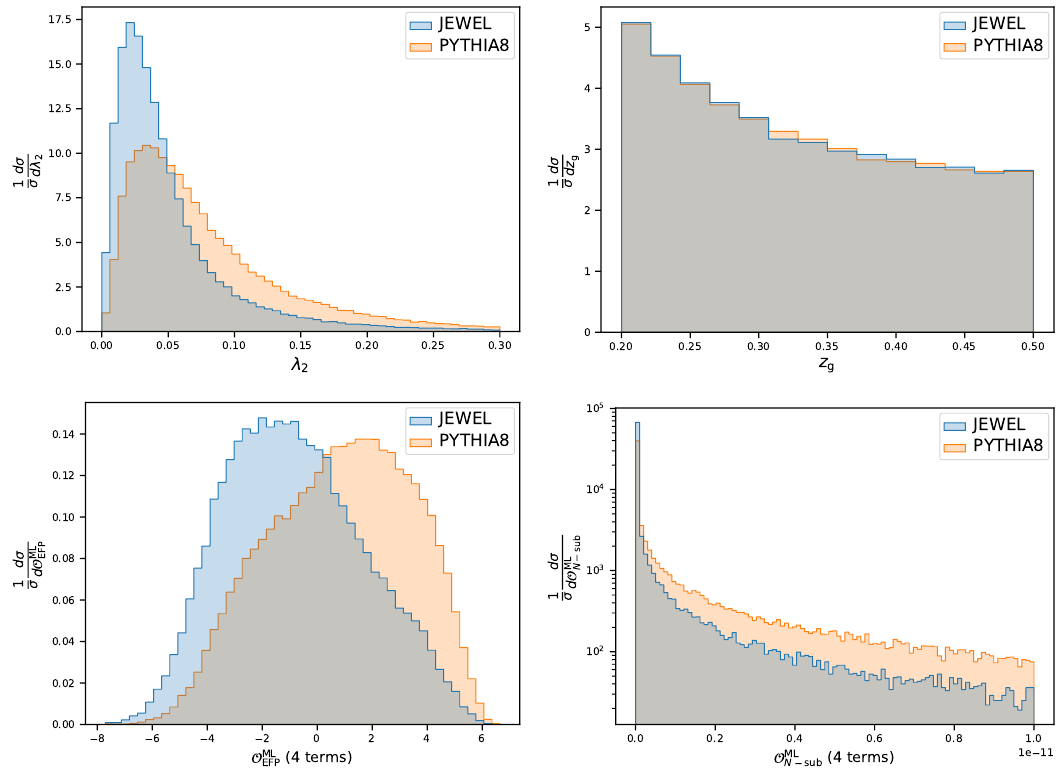
Figure 8 . Distributions of observables in pp and AA collisions which have already been mea- sured by experimental collaborations and examples of the machine-learned observables using the N -subjettiness and EFP